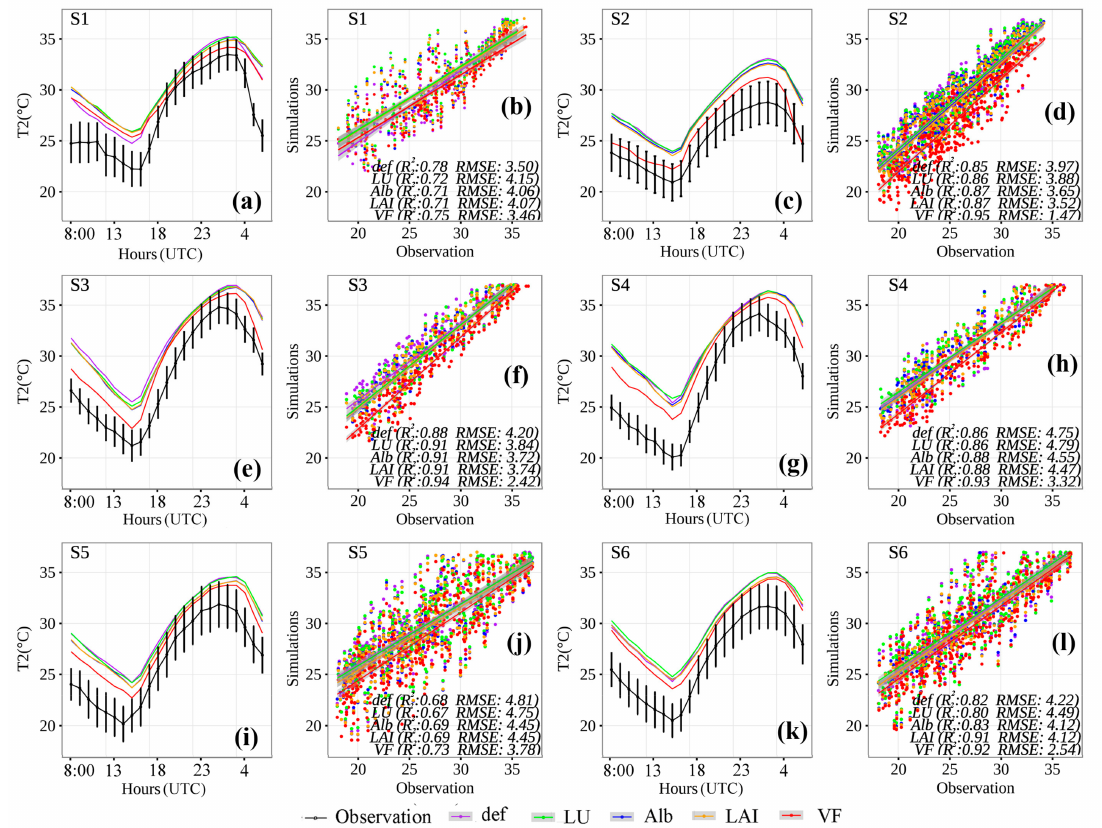
Figure 6. Comparisons of hourly averaged 2 m air temperature (T2) between observations and five simulations ( a , c , e , g , i , k ), and corresponding scatter diagram ( b , d , f , h , j , l ) at six stations (S1–S6) in 2010 and 2012. The five simulations are as follows: def (using default LU, albedo, LAI, and VF data); LU (using actual LU data), Alb (using actual LU and albedo data), LAI (using actual LU, albedo, and LAI), and VF (using all of actual LU, albedo, LAI, and VF